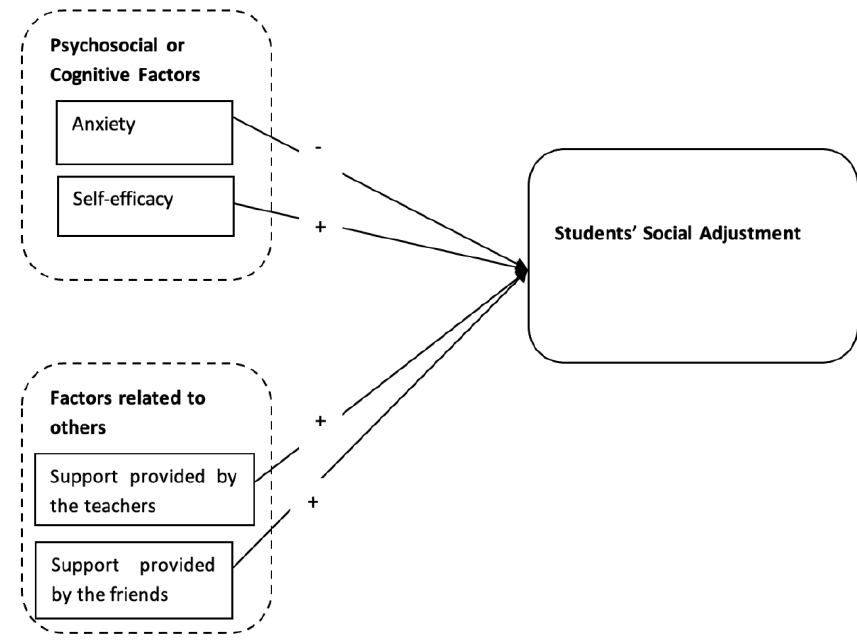
Figure 1. Theoretical framework